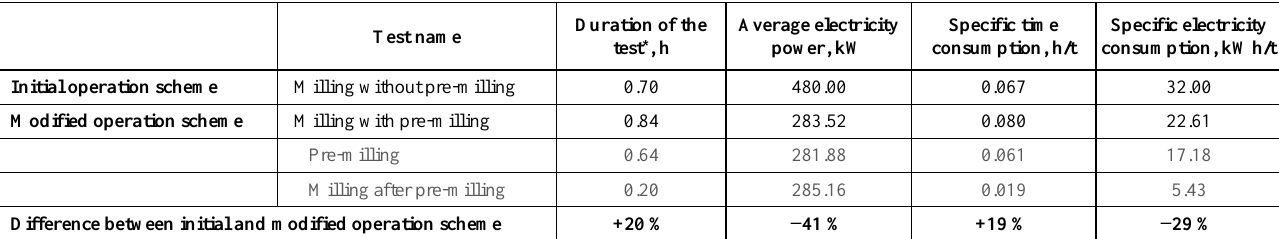
R ESULTS OF P ROPOSED M ODIFICATIONS AND THE C OMPARISON OF I NITIAL AND M ODIFIED O PERATION S